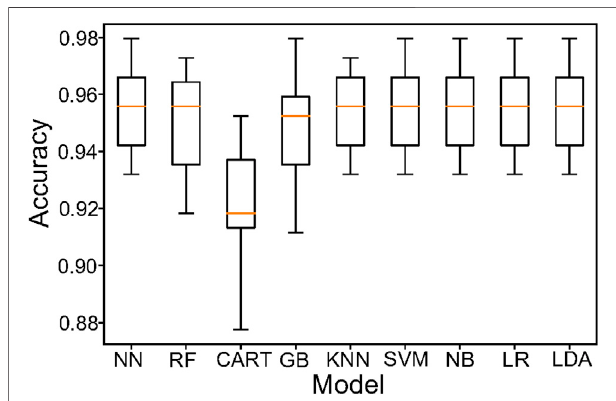
FIGURE 5 | Model comparison of EHR data. Using a box plot to re fl ect the classi fi cation characteristics of different models. The NN,RF,SVM, NB, LR and LDA are better than other